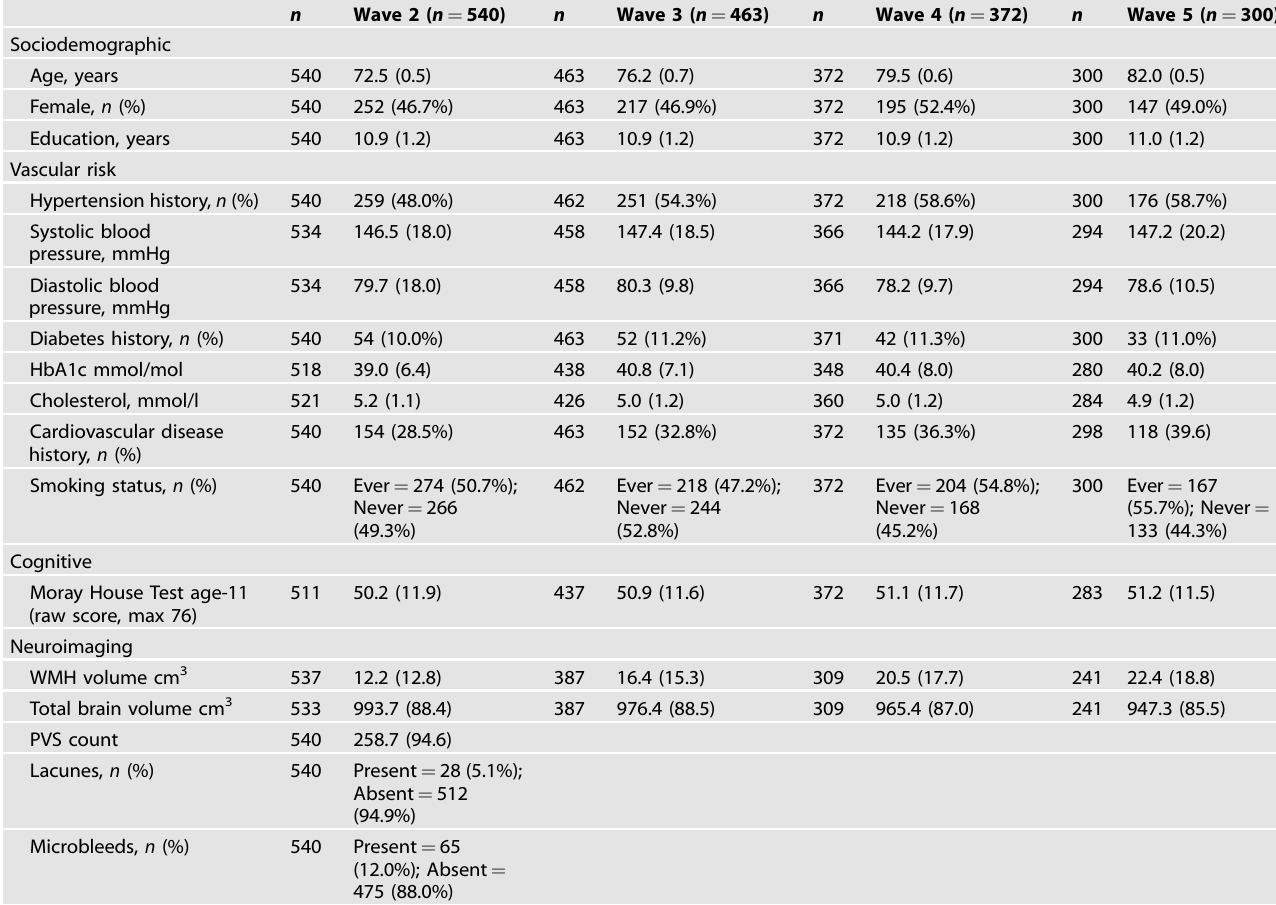
Table 2. Characteristics of the study sample at each